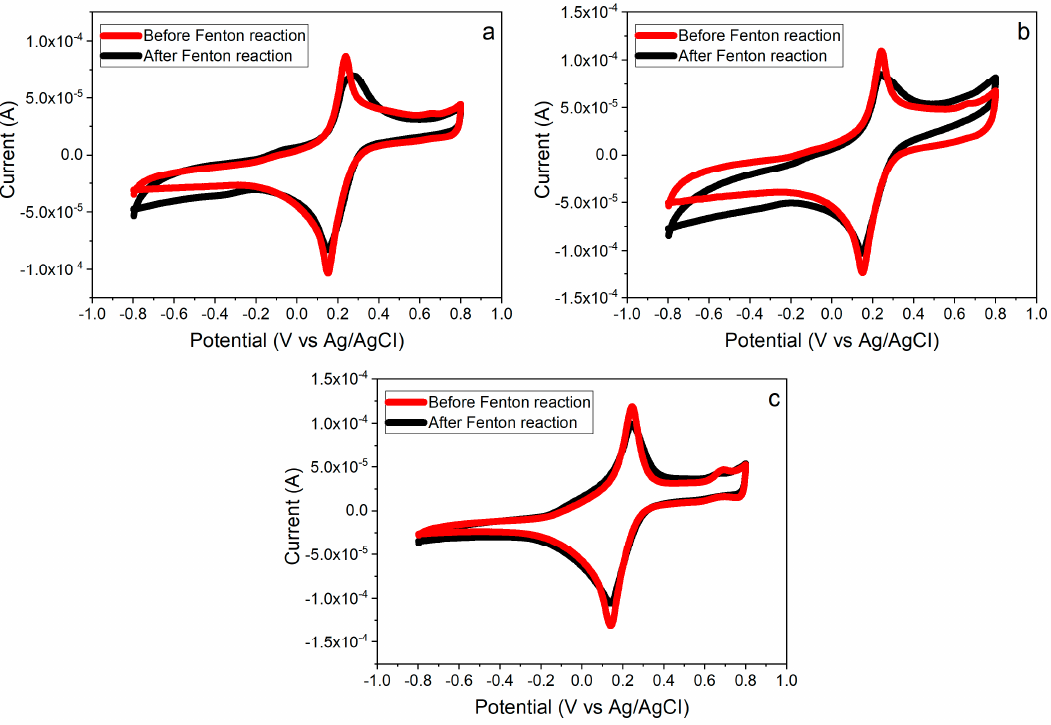
Figure 10. CV responses of ( a ) single layer of CeNP/GO composite on the PB modified GCE, ( b ) double layers of CeNP/GO composite on the PB modified GCE, and ( c ) triple layers of CeNP/GO composite on the PB modified GCE after running in the Fenton reaction.